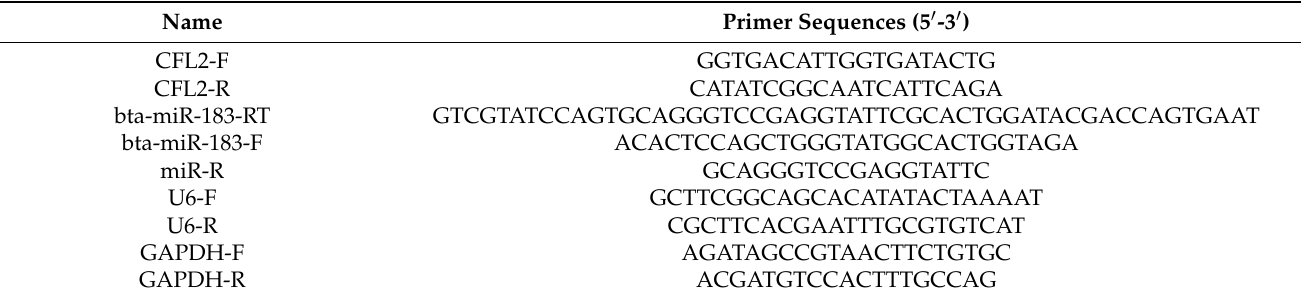
Table 3. Primer information for qRT-PCR.